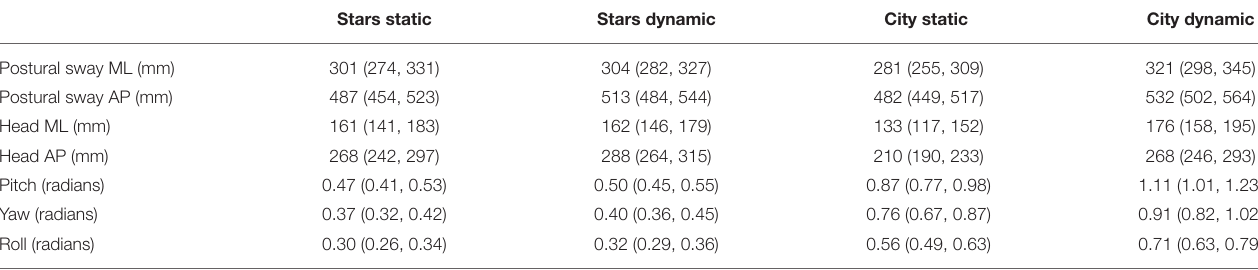
TABLE 3 | Directional path estimated marginal means in the response scale with 95% confidence intervals.